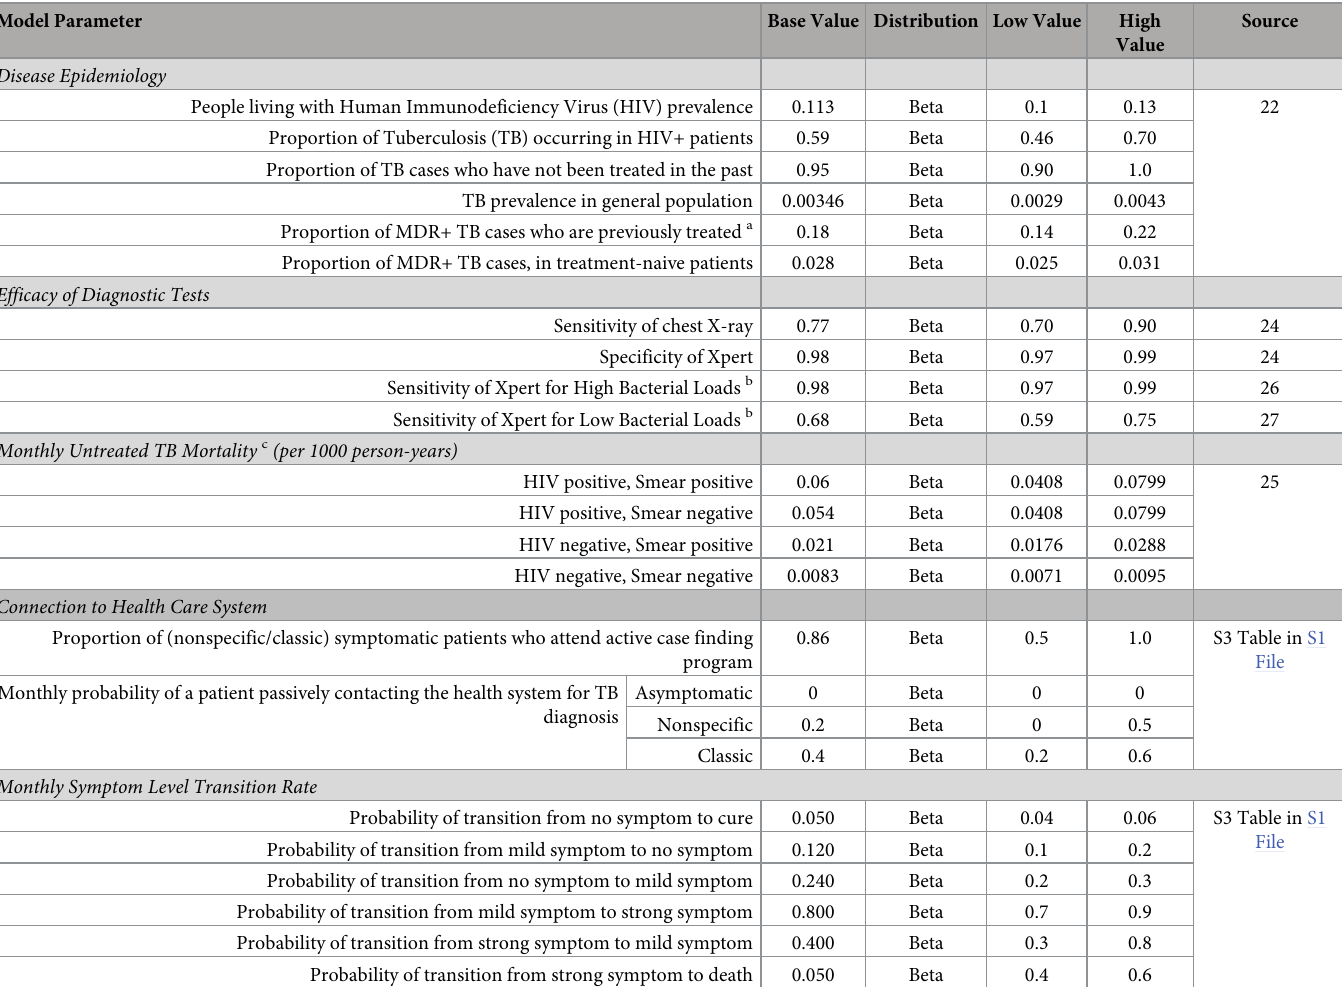
Table 1. Key model parameters.